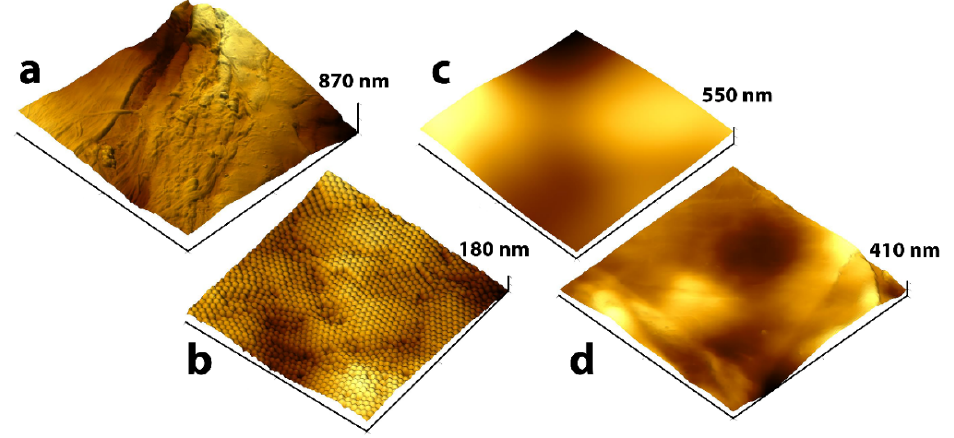
Figure 3. Three-dimensional AFM images of paper surface ( a ) before and ( b–d ) after treatment with pre-coating blends: ( b ) 8% PEVA emulsion, ( c ) 8% PVOH solution, and ( d ) 1% CC